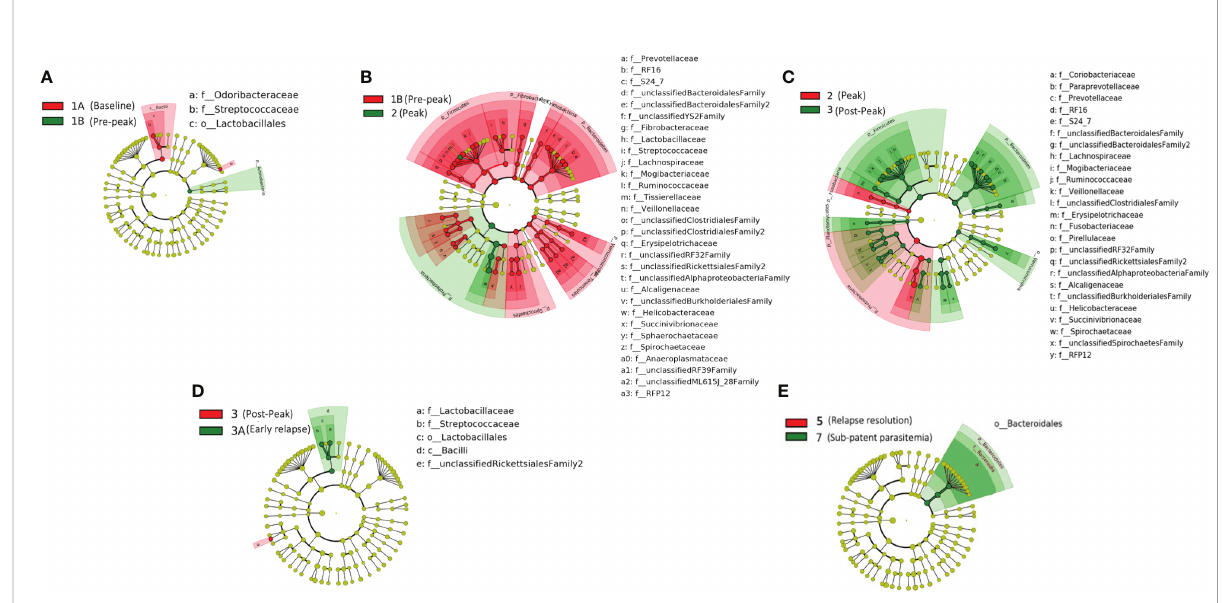
FIGURE 3 Taxonomic representation of statistically consistent differences between TPs during the longitudinal study of P. cynomolgi infection in rhesus macaques. LefSe cladograms from LDA analysis indicate signi fi cantly increased and decreased clades between TPs. (A) At the pre-peak stage (TP1B) Lactobacillus is decreased compared to baseline, and the phylum Actinobacteria is increased, although none of its contained clades were individually increased. (B) Between pre-peak (TP1B) and peak (TP2) 28 families decreased in abundance. Two families increased in abundance: Helicobacterceae and Tissierellaceae , both of which are anaerobic or aerotolerant. (C) Many taxa which decreased between pre-peak and peak infection (TPs 1B and 2) increased between peak and post-peak (TPs 2 and 3) indicating at least a partial restoration of the gut microbiome post-peak. (D) Lactobacillus continues to increase between post-peak and early relapse (TPs 3 and 3A). (E) While no signi fi cant changes were seen in the peak relapse (TP4), or relapse resolution (TP5), the bacteroidetes phylum is increased in the sub-patent samples compared to the relapse resolution (TPs 5 and 7). The insigni fi cant data resulting from the TP3A/TP4 and TP4/TP5 comparisons is not shown in this fi